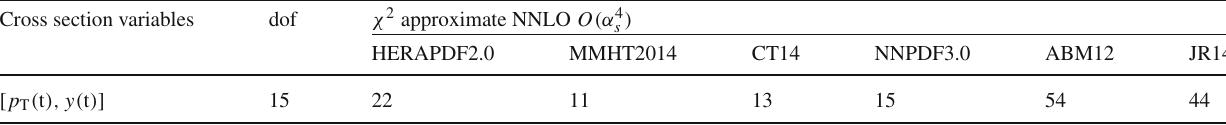
Table 3 The χ 2 values and dof of the double-differential normalized tt cross sections with respect to approximate NNLO O (α 4 s ) theoretical calculations [4,19,69,70] using different PDF sets Cross section variables